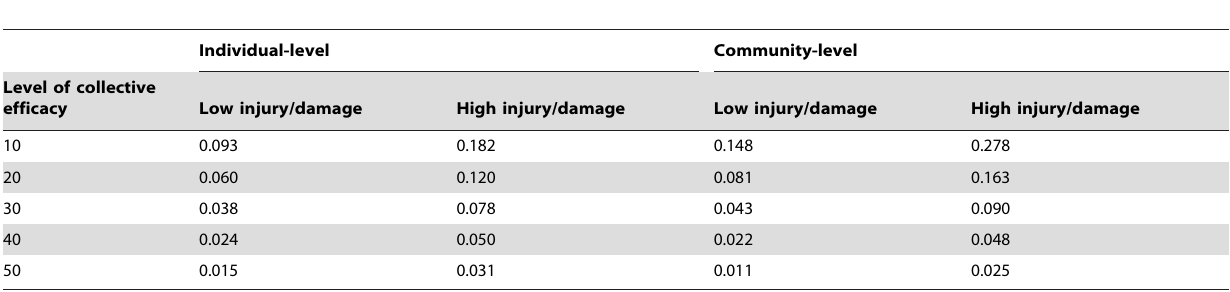
Table 5. Estimated marginalized probabilities of probable PTSD across five collective efficacy scores by level of injury/damage.